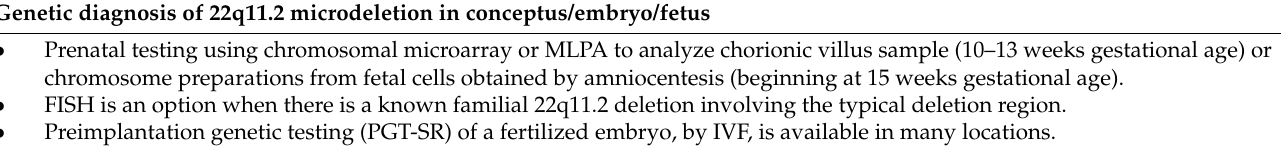
Table 4. Prenatal guidelines for the 22q11.2